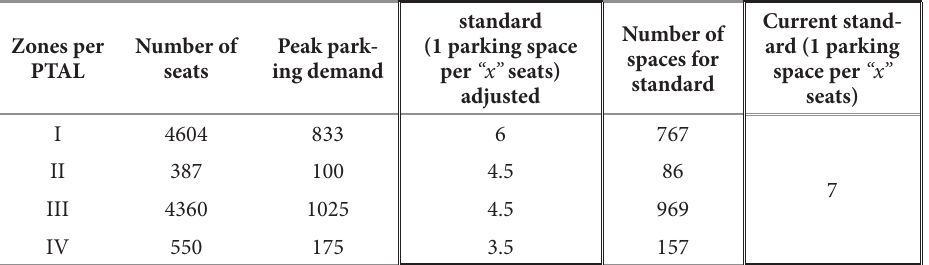
Table 10. Analysis of obtained parking spaces per zones Zones per